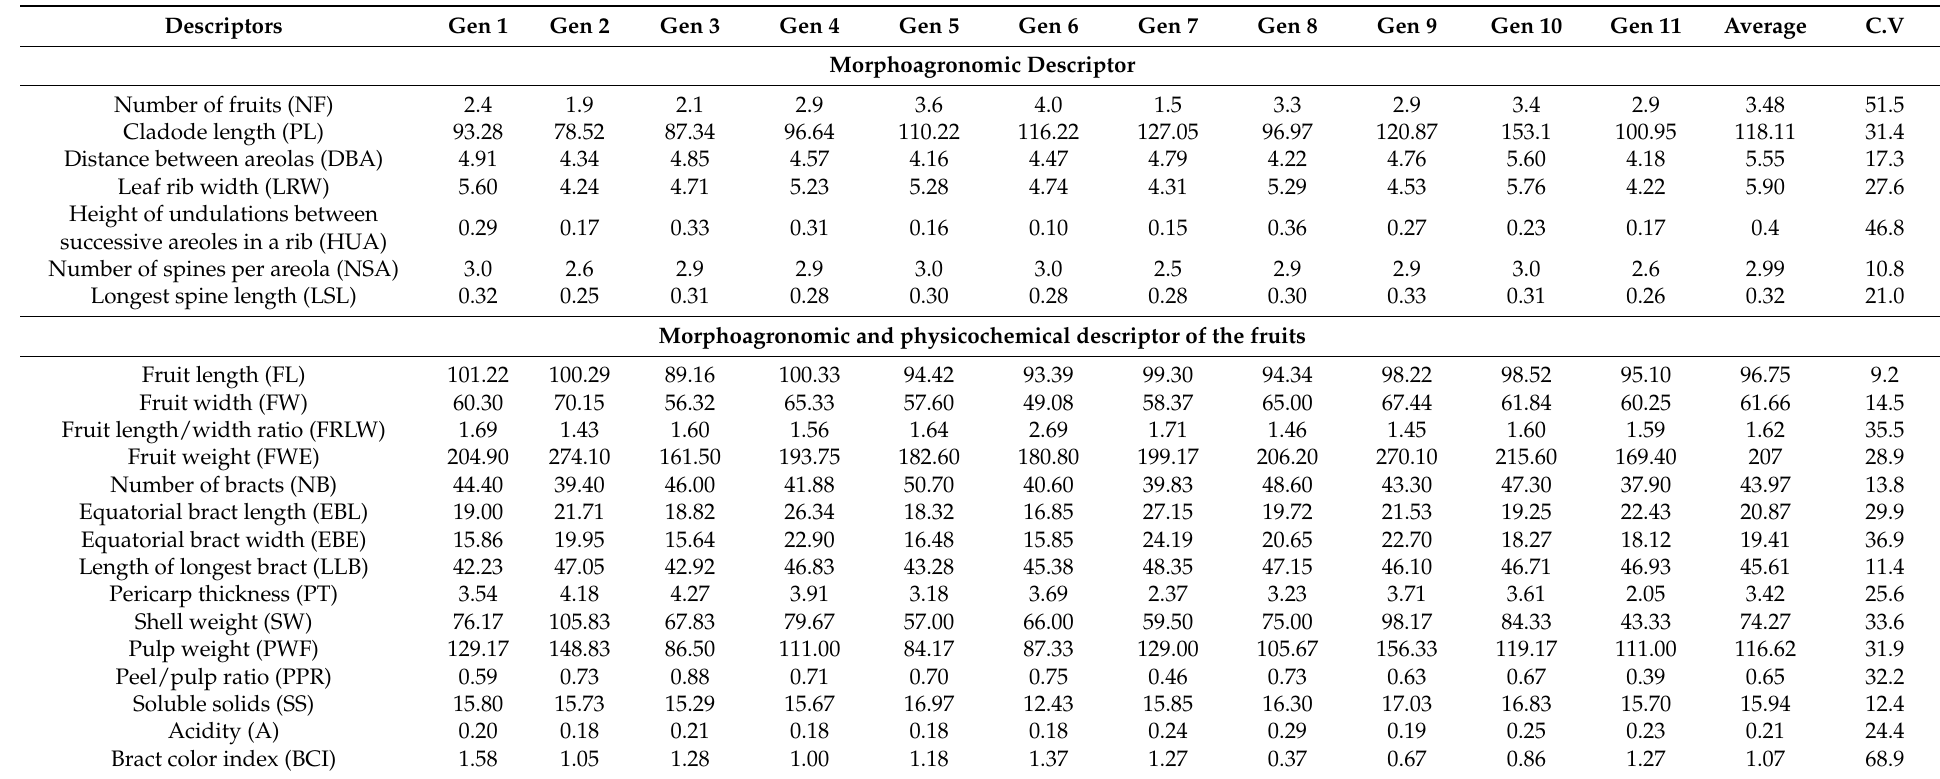
Table 1. Descriptive statistics of the quantitative morphoagronomic and fruit descriptors of the yellow pitahaya